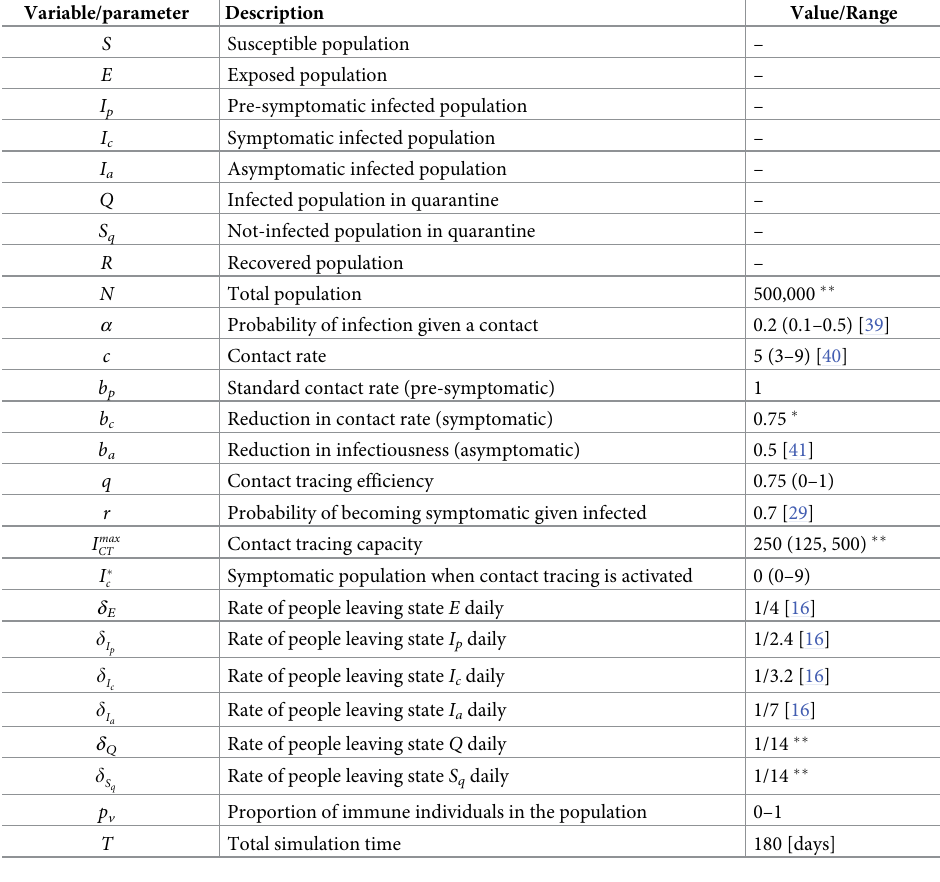
Table 1. Brief description of the variables and parameters of the model given in Eq (11), with corresponding default values or ranges considered for the simulations. Values in brackets correspond to the explored